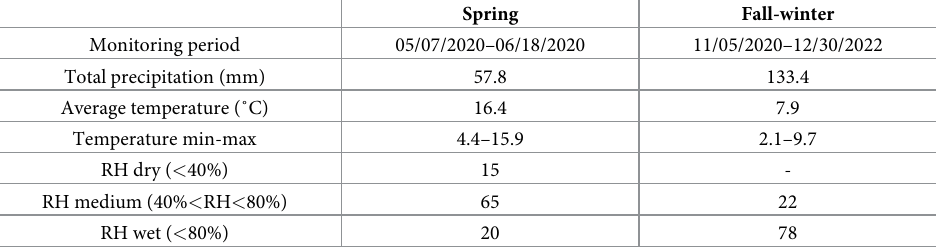
Table 1. Climatic data.